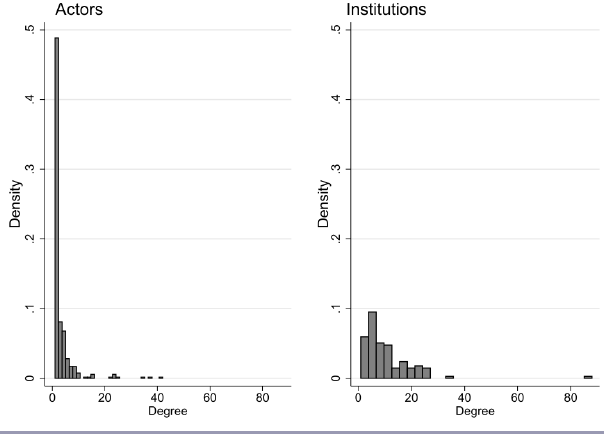
Fig. 4 . Degree distributions for actors and institutions.